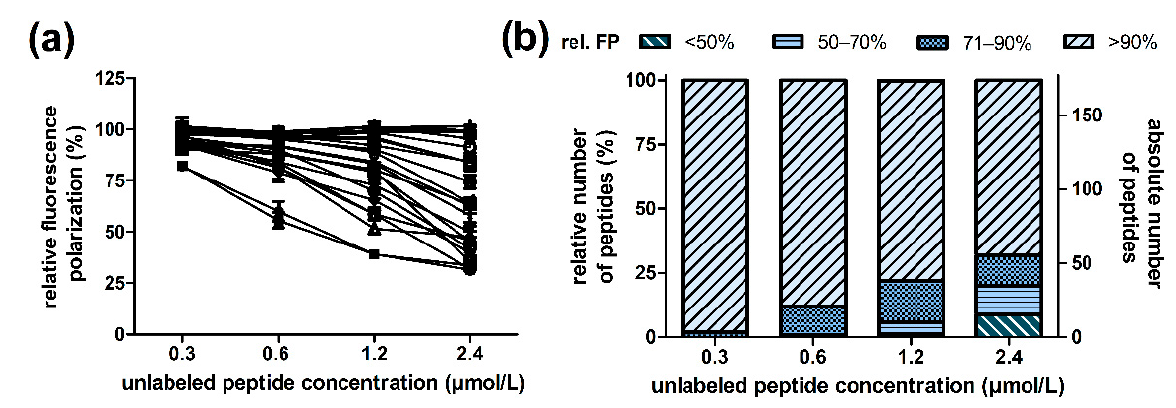
Figure 2. Inhibitory fluorescence polarization assay of ARV-1502 analogs using E. coli 70S ribosome and Cf-ARV-1502 in competition with unlabeled peptide concentrations of 0.3, 0.6, 1.2, and 2.4 µmol/L ( a ) and number of analogs able to displace Cf-ARV-1502 at the indicated concentrations ( b ). Relative FP of 25 randomly chosen peptides with different inhibitory effects ( a ). Unlabeled peptide concentration-dependent distribution of peptides for defined relative FP ranges (<50%, 50–70%, 71–90, and >90%) ( b ). Low FP values indicate stronger competition to the unlabeled ARV-1502 analog. The relative FP value of the control samples without unlabeled peptide was set to